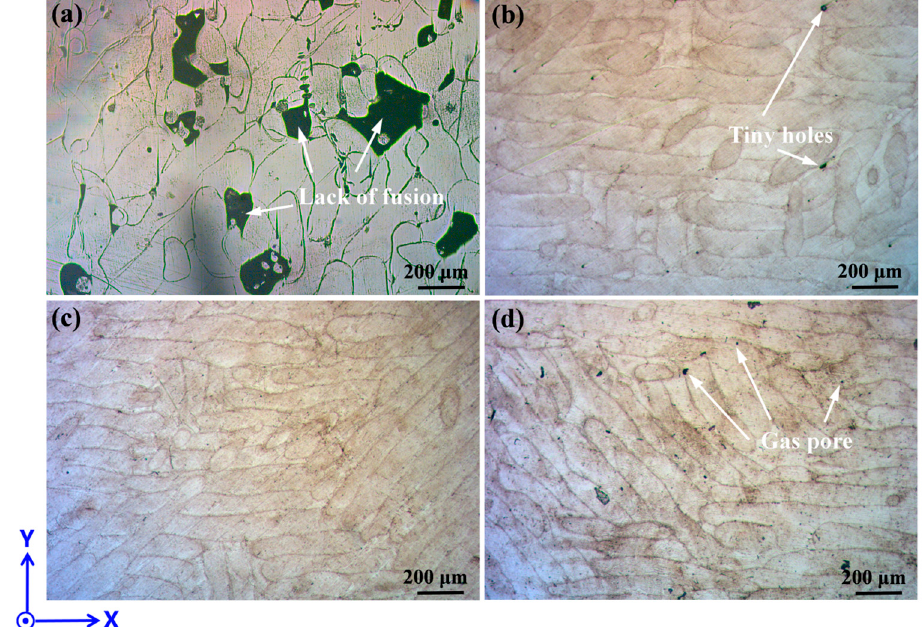
Figure 5. Optical micrographs of the as-SLMed IN718 samples on vertical section (X–Y plane) at the E v of ( a ) 41.67 J/mm 3 , ( b ) 85.86 J/mm3, ( c ) 100 J/mm 3 , and ( d ) 117.17 J/mm 3 .